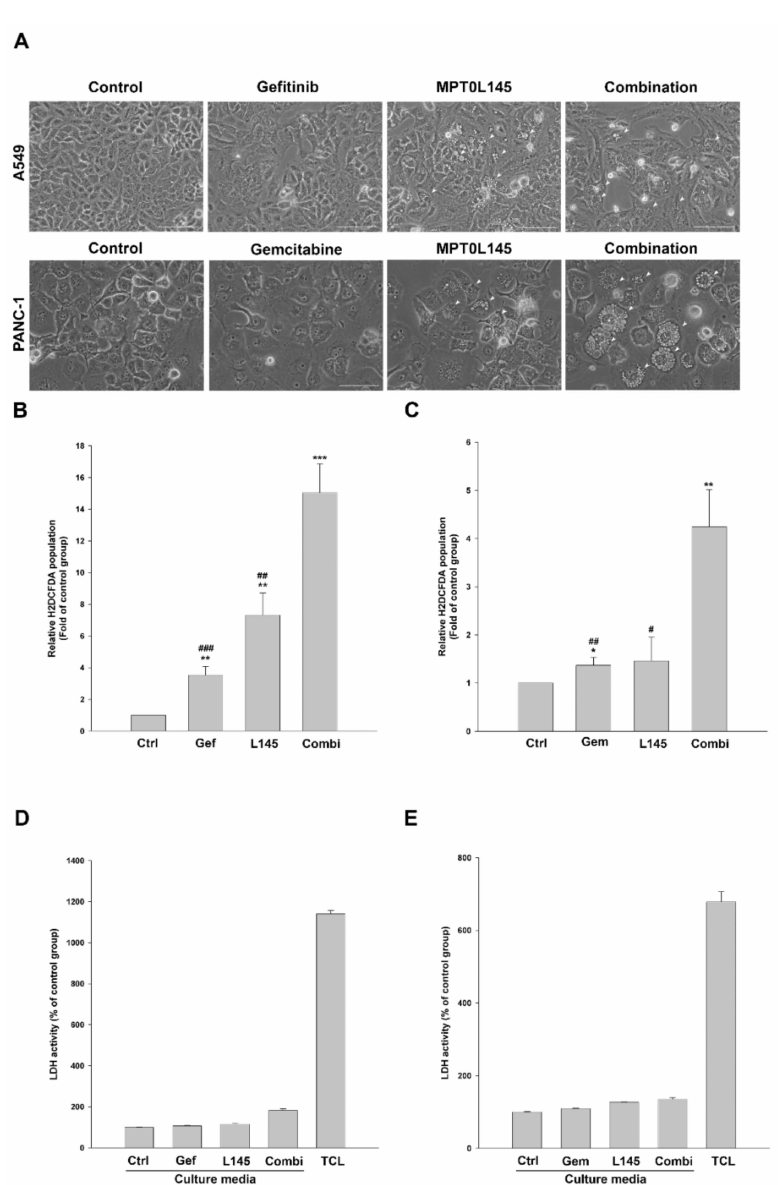
Figure 6. Drug combination increases intracellular vacuolization and reactive oxygen species (ROS) level in cancer cells. ( A ) A549 (upper panel) and PANC-1 (lower panel) cells were exposed to MPT0L145 (4 µ M) alone and in combination with gefitinib (10 µ M) or gemcitabine (100 µ M) for 48h, respectively. Cell morphology was examined with the EVOS XL Core Cell Imaging System (Thermo Scientific). Intracellular vacuoles are indicated by white arrowheads. Scale bars: 100 µ m. ( B ) A549 and ( C ) PANC-1 cells were treated with MPT0L145 (L145, 4 µ M) in the presence of gefitinib (Gef, 10 µ M) or gemcitabine (Gem, 100 µ M), respectively for 72h. The cells were stained with H 2 DCFDA and intracellular ROS levels were measured by flow cytometry. Data are expressed as means ± S.D. ( N = 3, * p < 0.05, ** p < 0.01 compared to control group; # p < 0.05, ## p < 0.01, ### p < 0.001 compared to combination group). ( D ) A549 and ( E ) PANC-1 cells were treated with MPT0L145 (L145, 4 µ M) in the presence of gefitinib (Gef, 10 µ M) or gemcitabine (Gem, 100 µ M), respectively for 72h. Culture media or total cell lysates (TCL) from untreated cells, which served as maximum LDH release control, were collected and subjected to LDH analysis. Data were represented by the percentage of control